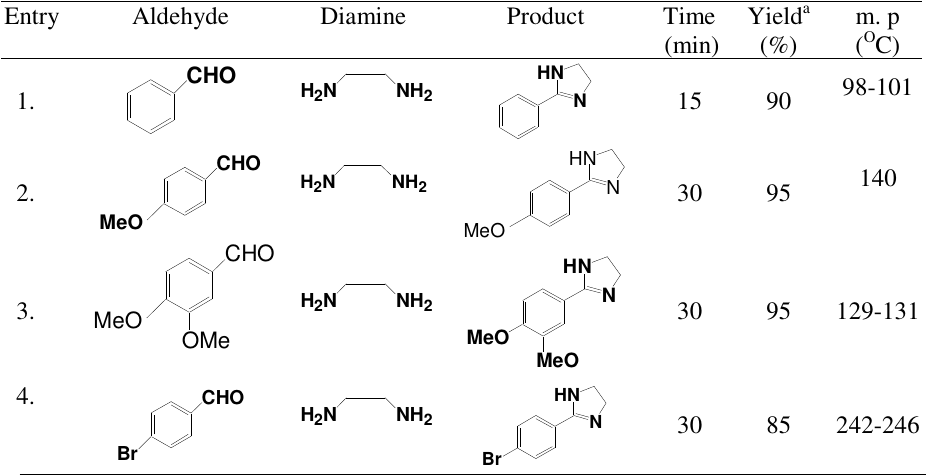
Table 1 . Synthesis of imidazolines and benzimidazoles from aldehydes and 1,2- Diamines.